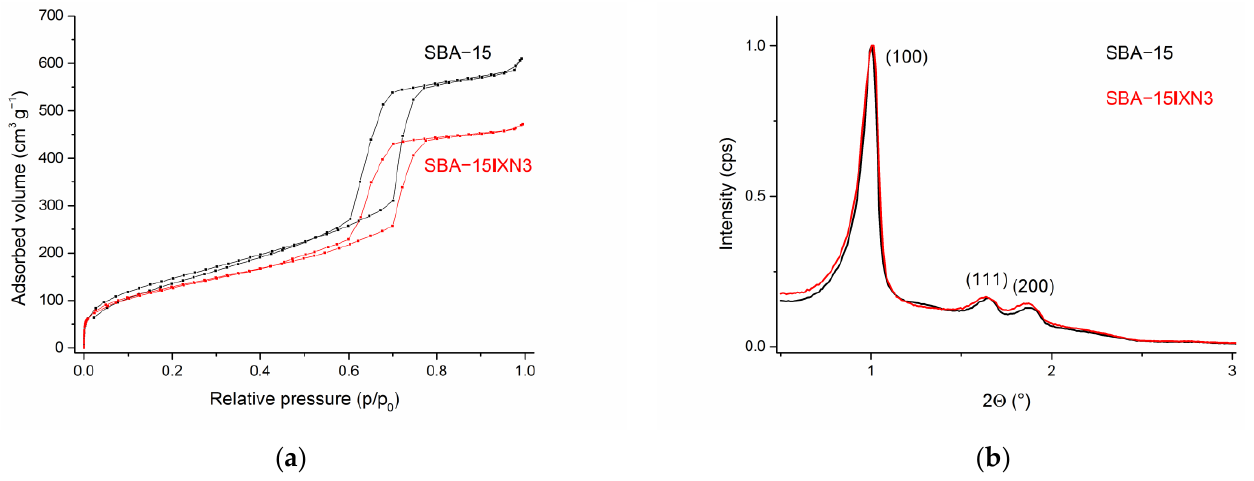
Figure 3. N 2 adsorption-desorption isotherms ( a ) and SAXS pattern of SBA-15 and SBA-15|XN3 ( b ).